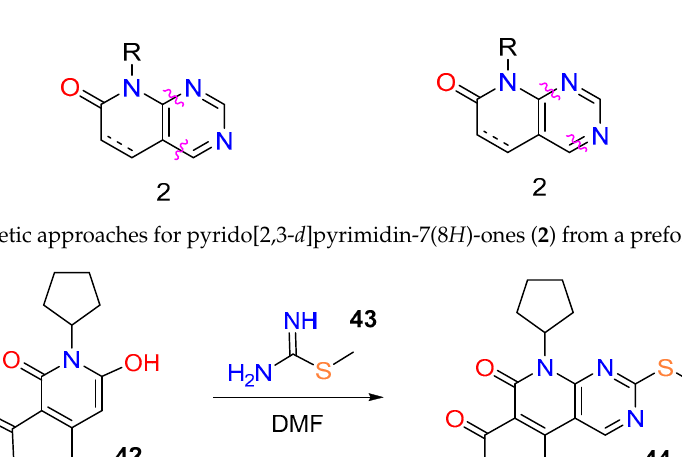
Figure 16. Synthetic approaches for pyrido[2,3- d ]pyrimidin-7(8 H )-ones ( 2 ) from a preformed pyridone .